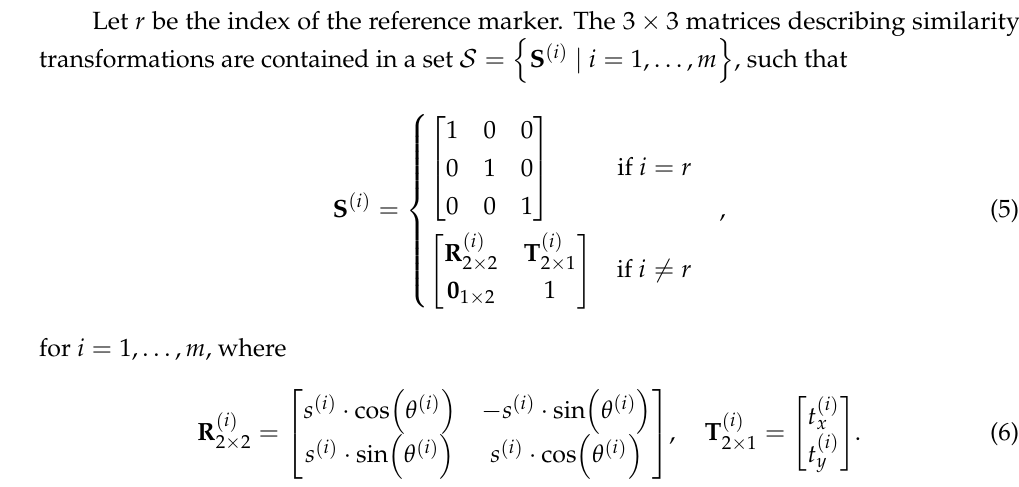
Figure 3. A system diagram describing the general idea behind our method. ( a ) The input consists of a many-to-one point correspondence specified by geometrically similar markers and information about the shape of the target marker. ( b ) We assume that the isolated homographies corresponding to each independent marker are provided on the input as well. ( c ) The algorithm processes each marker by applying its homography matrix to the image to produce a rectified image. Subsequently, it computes optimal similarity matrices corresponding to the auxiliary markers. The computation of the score function makes use of these transformations. The obtained score values then serve for comparison to rank (sort in ascending order) the homographies. The homography ranked first is considered the “best” candidate for the minimal reprojection error over the entire